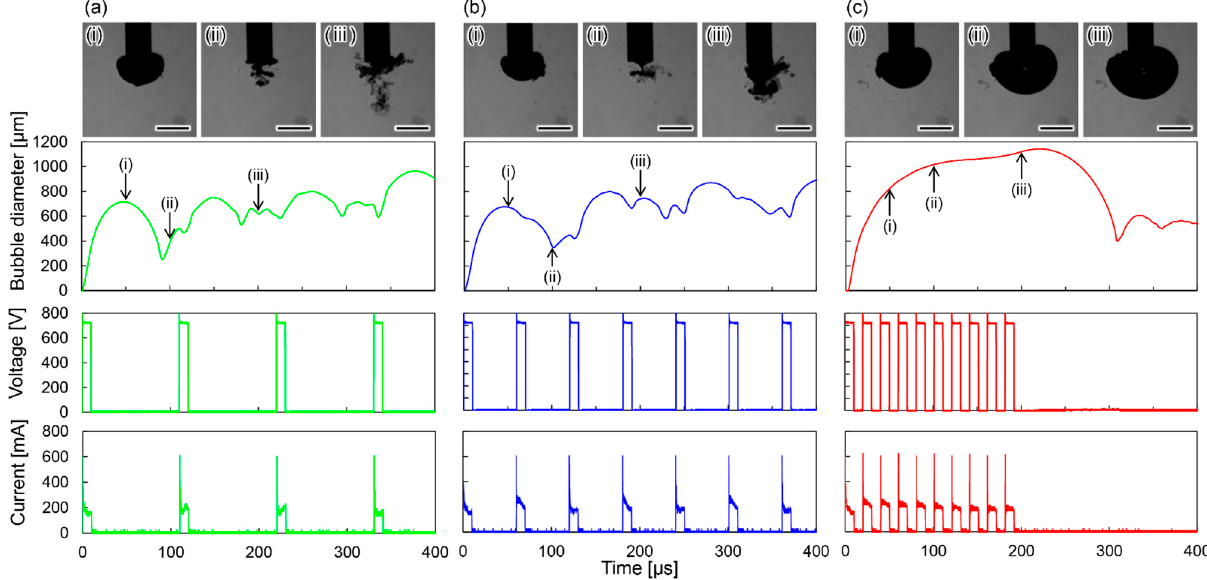
Figure 3. Photographs of micro-plasma bubbles at ( i ) 50 µ s, ( ii ) 100 µ s and ( iii ) 200 µ s after application of a pulse and time series data of the bubble diameter, voltage and current. All scale bars are 100 µ m. The voltage is 700 V, the pulse width is 10 µ s, and the number of pulses is 10. In ( a – c ), the off times are 100 µs, 50 µs and 10 µs, respectively.